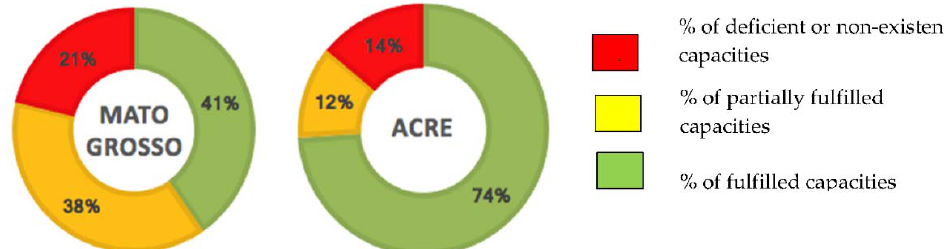
Figure 1. Comparison between the performance of Mato Grosso and Acre’s capacities, based on the score attributed to the set of thematic blocks evaluated by the Options Assessment Framework (OAF) methodology (data from the OAF application).